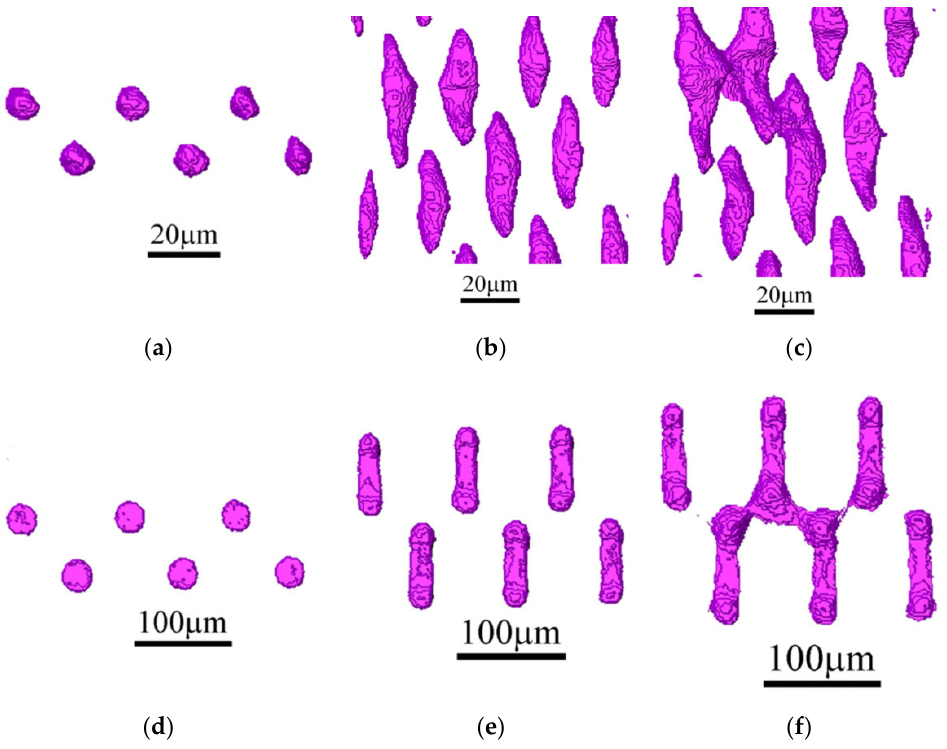
Figure 14. Growth and coalescence of modelled holes in copper specimens at true strain levels: ( a ) 0.00; ( b ) 0.77; ( c ) 1.01; in Glidcop alloy specimens at true strain levels: ( d ) 0.00; ( e ) 0.45; ( f ) 0.50 [80].